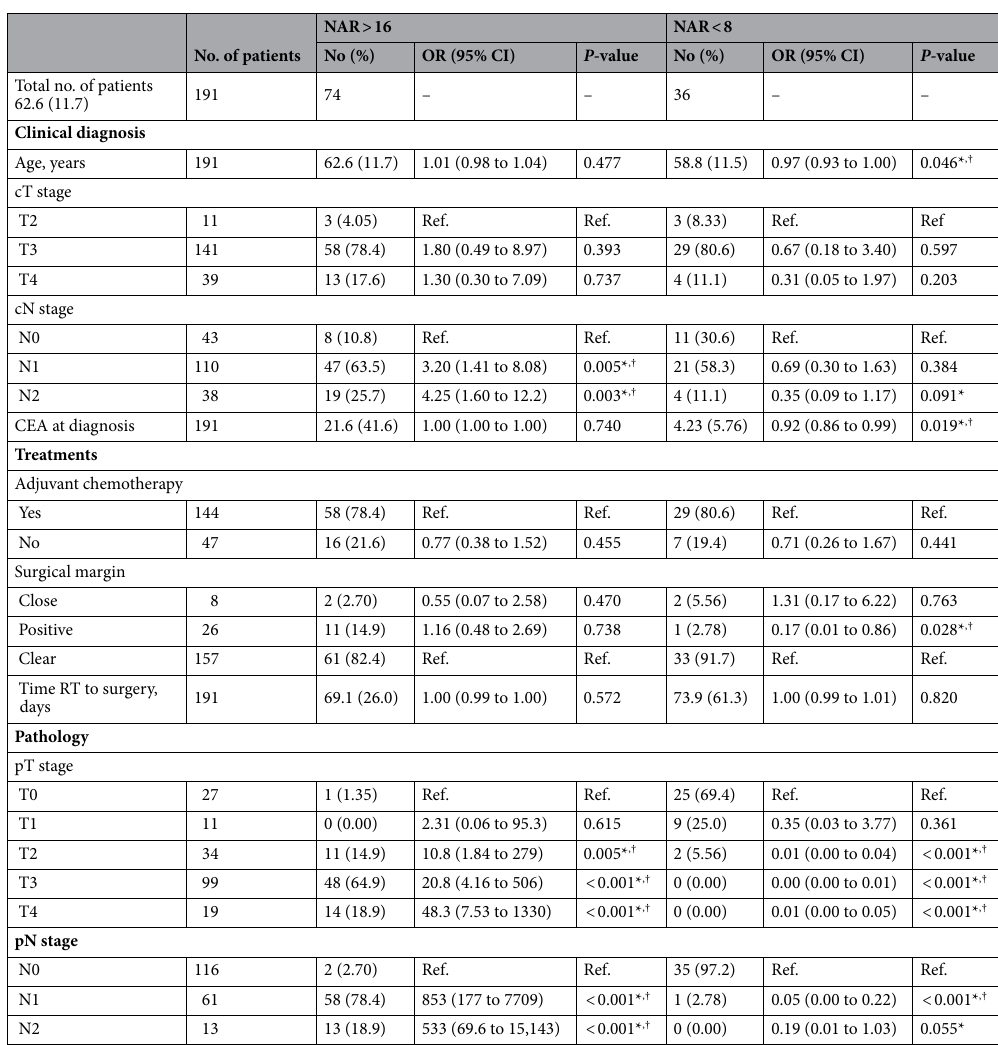
Table 1. Baseline NAR characteristics of the patients. * P < 0.1, † P < 0.05. The data are shown as the number (percentage) or median (interquartile range). CEA carcinoembryonic